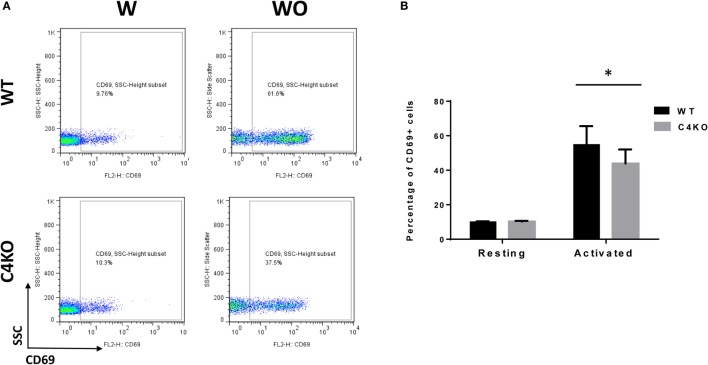
Effect of C4 deficiency on T cell activation. CD4+ T cells purified from naïve wild-type (WT) and C4 KO mice were incubated with (w) or without (w/o) anti-CD3 and anti-CD28 mAbs for activation for 5 h, then the percentage of activated T cells (CD69+) in the total cells was quantitated by flow cytometry. (A) Representative flow cytometric analysis results. (B) Summarized results from three independent experiments. Mean ± SEM. *p < 0.05 by paired t-test.